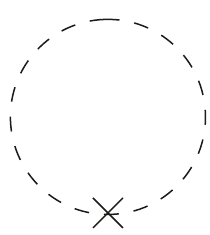
Figure 2 . The Feynman diagram that contributes at one-loop level to the energy-momentum tensor of a real scalar field. The dashed circle denotes the scalar propagator and the cross denotes the energy-momentum tensor